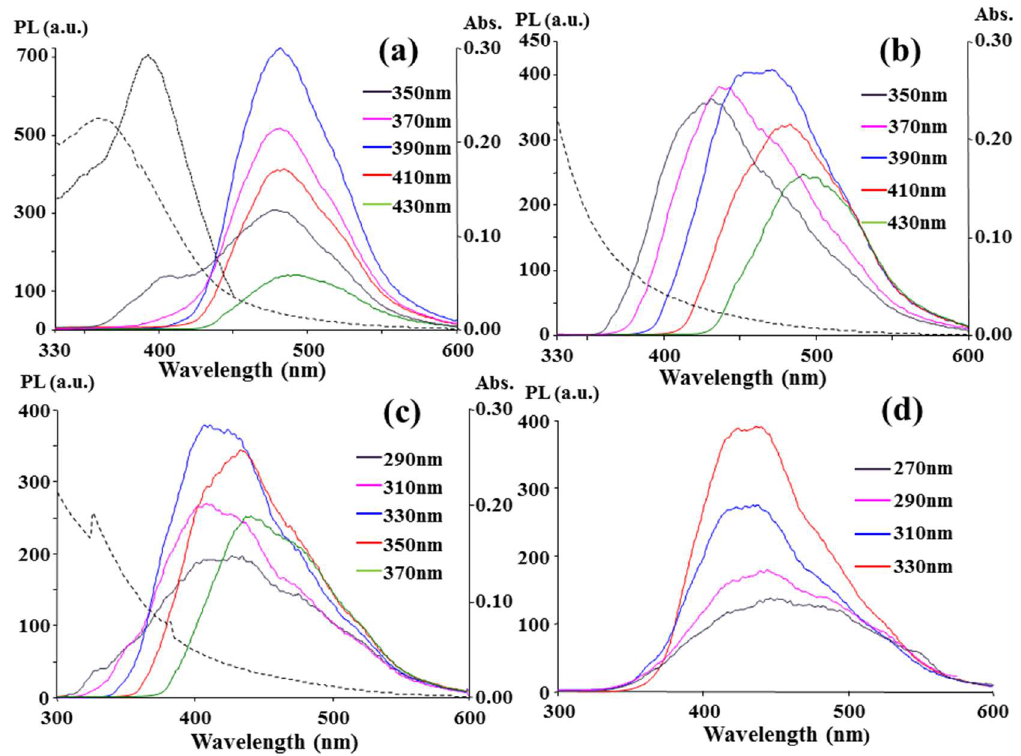
Figure 1. Fluorescence spectra of ( a , d ) CA + [EMIM]N(CN) 2 ; ( b ) [EMIM]N(CN) 2 ; and ( c ) CA + glycerol treated by O 2 /CCP ( a , b , d ) and N 2 /CCP ( c ). The mixtures of CA (100 mg) and solvents (500 µ L) were treated by CCP (10 sccm of gas flow, RF power 90 W, 30 min). After the addition of 1.0 mL of H 2 O to the treated products, different volumes of the product solutions (0.2 µ L for ( a , d ) and 20 µ L for ( b , c ) were separately transferred to cuvettes filled with 3.0 mL of H 2 O for spectrometric measurements. (—) and ( ···· ) curves denote UV-Vis absorption and PL (emission at 480 nm) spectra, respectively.